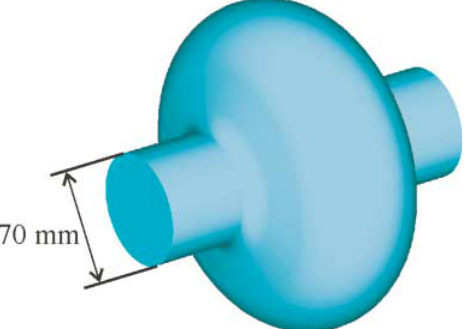
FIG. 1. (Color) A single cell resonator similar to the TESLA cavity with infinitely long beam tubes at both